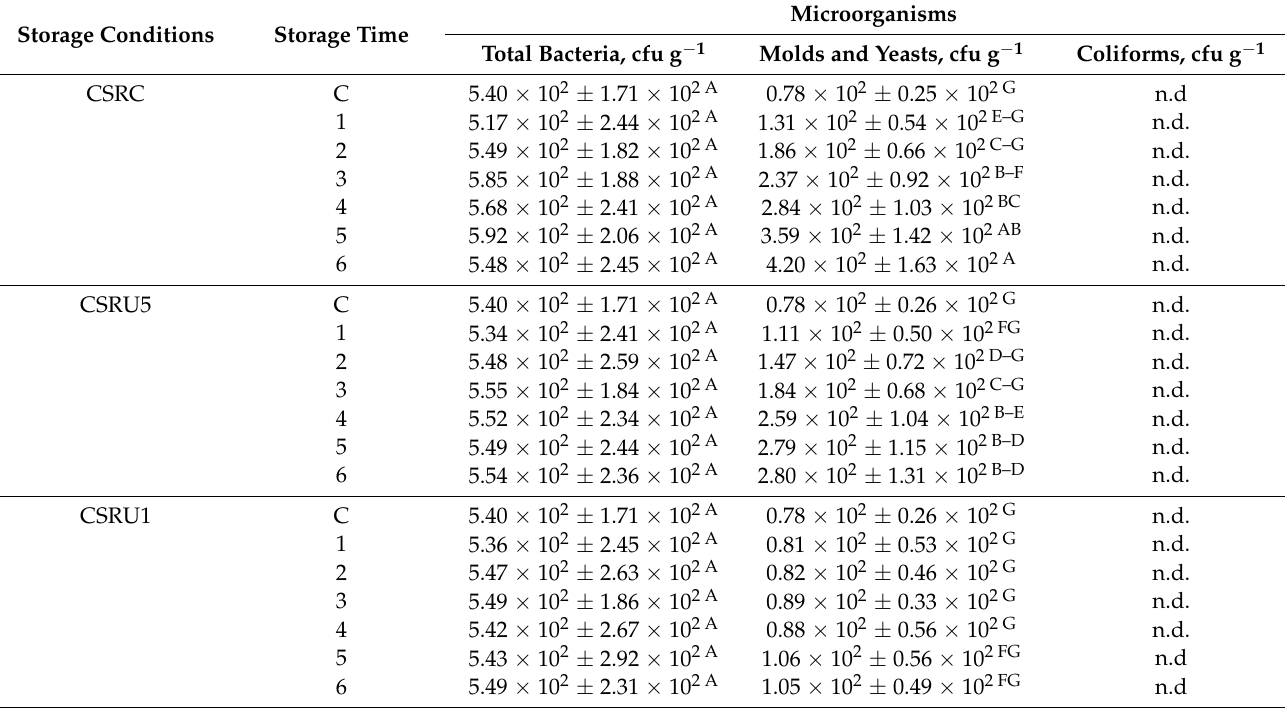
Table 4. Comparison of the mean values ± standard deviation of the total counts of mesophilic aerobic bacteria, yeasts and molds, and coliforms before (C) and during the storage times from 1 to 6